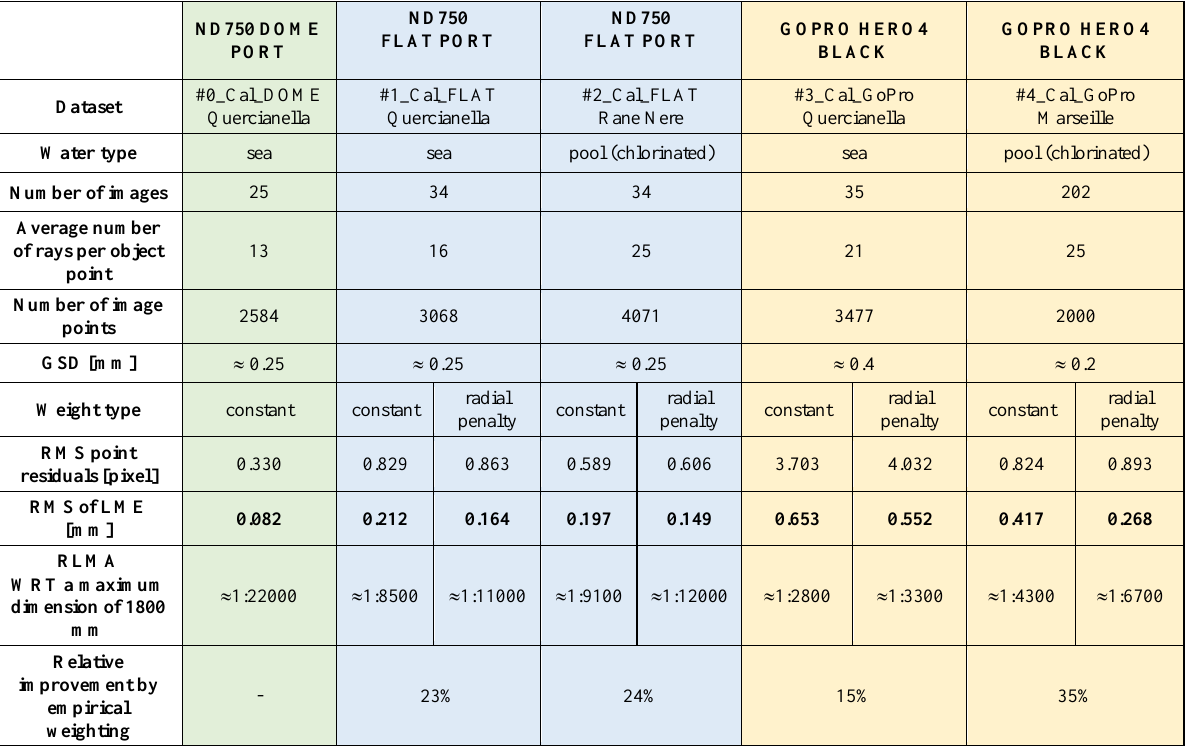
Table 1. Summary of length measurement error from the different bundle adjustment results on the calibration test object